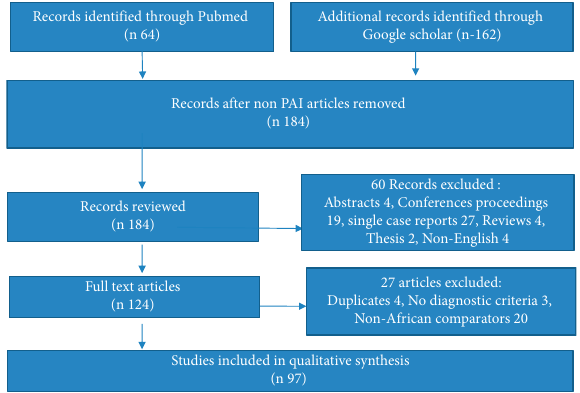
Figure 1: Flowchart of the article screening and selection